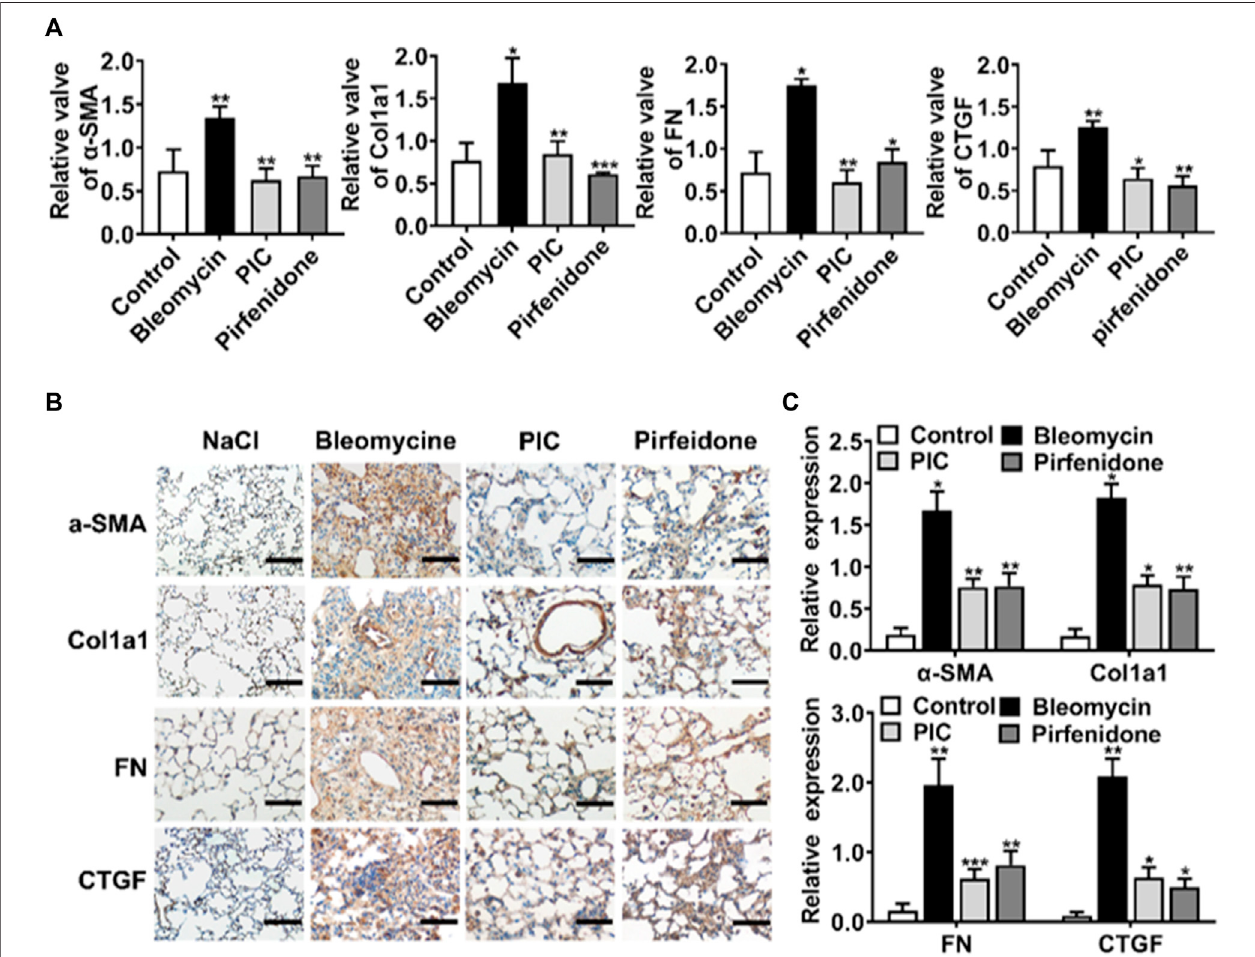
FIGURE 5 | (A) mRNA expression levels of α -SMA, Col1a1, FN, and CTGF in lung homogenates of indicated groups. (B) Representative images showing immunohistochemical staining of α -SMA, Col1a1, FN, and CTGF of lung sections from the indicated groups of mice and images at 200× magni fi cation. (C) Expressions of protein were performed by ImageJ in different groups. Data are expressed as mean ± SD, n = 6. * p < 0.05, ** p < 0.01, and *** p < 0.001.